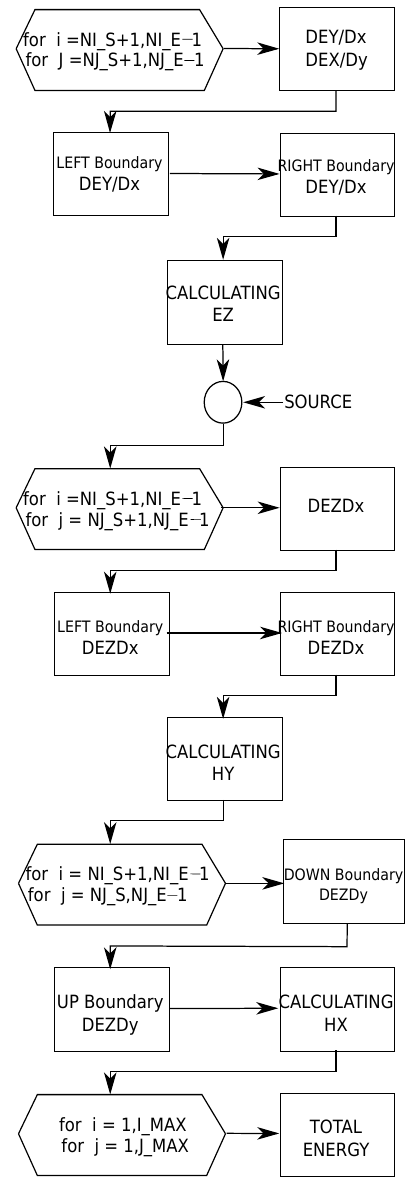
Figure 3. Flux diagram showing the four cycles necessary if the convolutional variables are allocated in all the computational domain. The cycles are labeled as V 1 , V 2 , V 3 and V 4